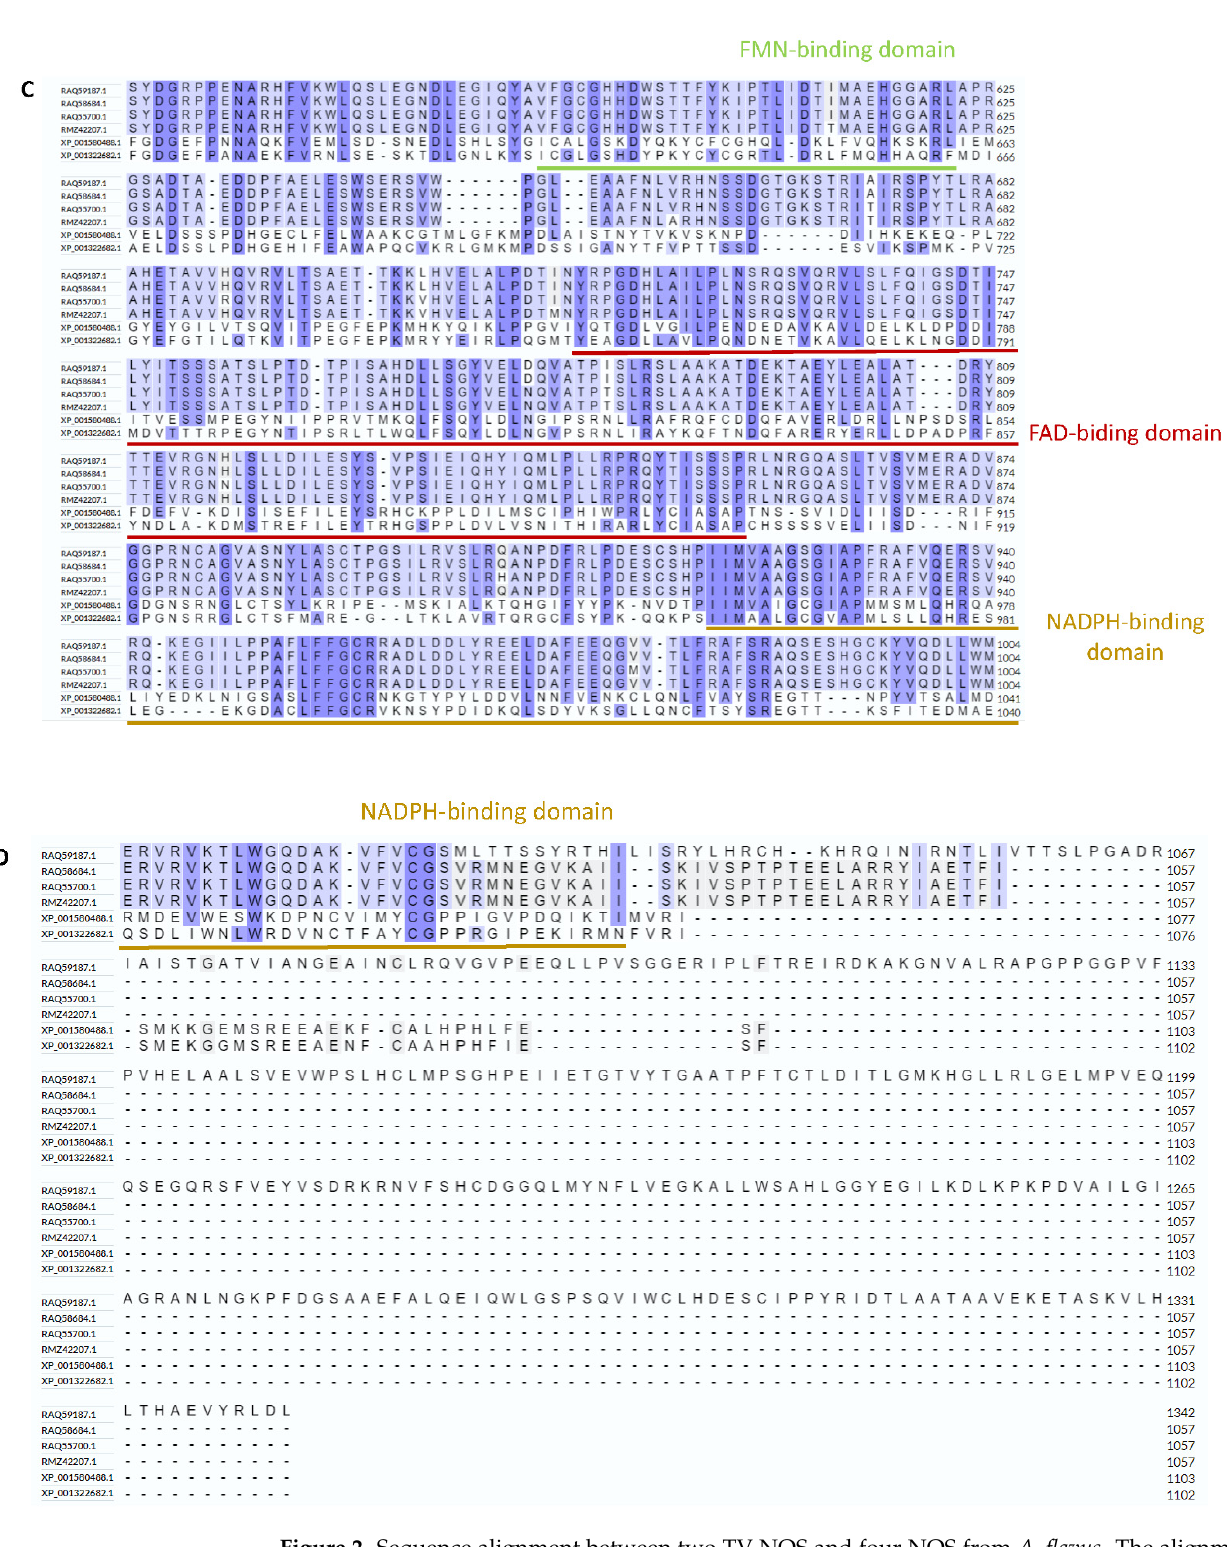
Figure 2. Sequence alignment between two TV NOS and four NOS from A. flavus . The alignment was obtained using UniPort alignment tools followed by a manual modification. The conserved NOS domains and motifs, including Heme, BH4, CaM, FMN, FAD, and NADPH binding domains, are marked with blue boxes. ( A ) Heme binding domain prediction binding site ( B ) BH4 domain and CaM prediction biding sites ( C ) FAD and NADPH prediction binding sites ( D ) NADPH prediction binding site